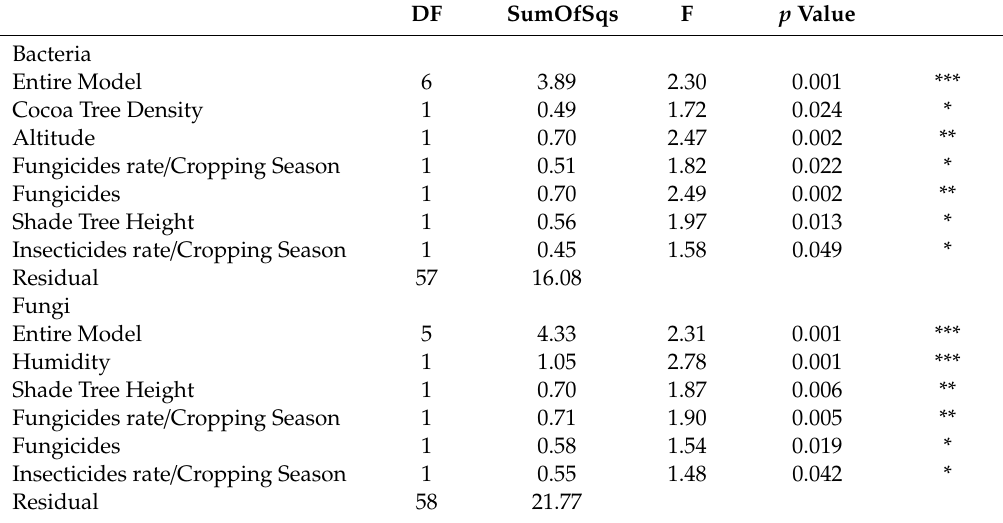
Table 2. Results of the db-RDA that describes the e ff ect of environmental properties and agroforestry management systems on endophyte community composition in T. cacao leaves.